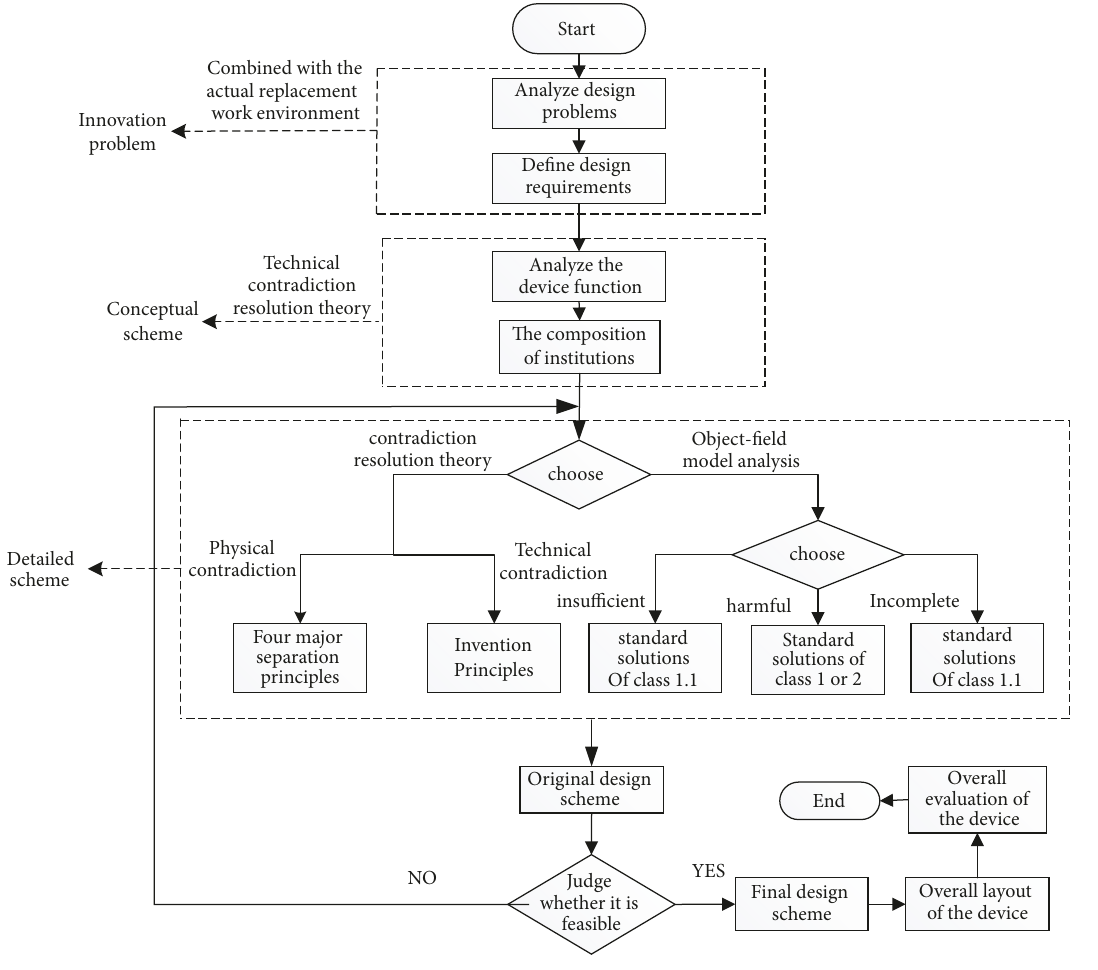
Figure 3: Design flow chart. Table 1: The resolution of technical